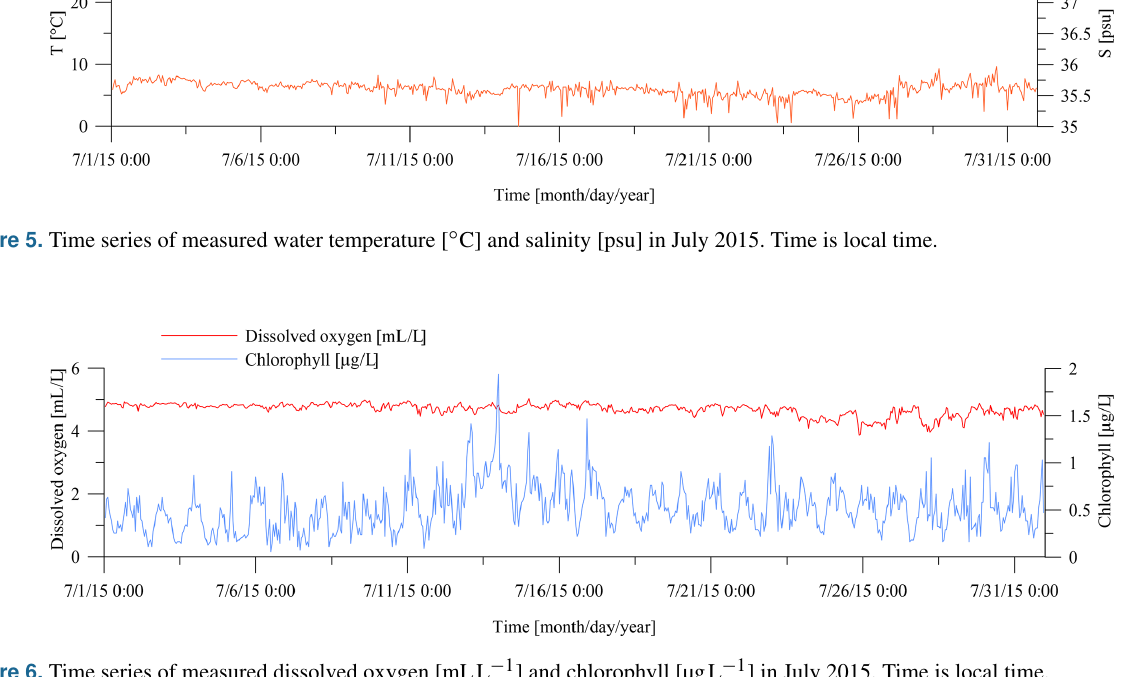
Earth Syst. Sci. Data, 13, 599–607, 2021